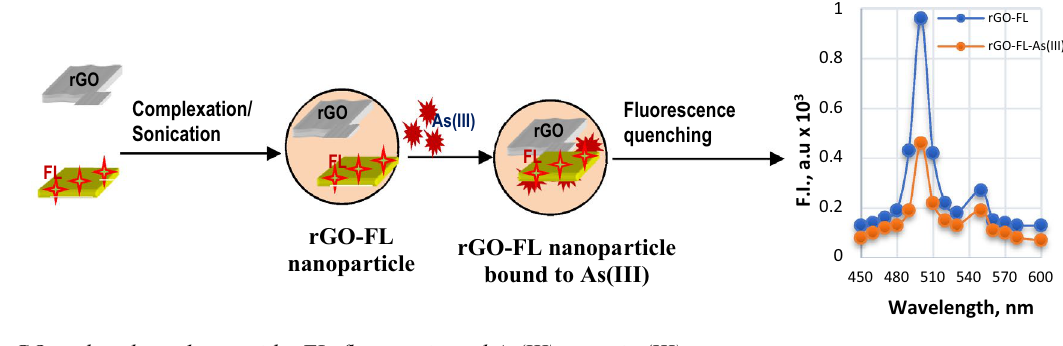
rGO, reduced graphene oxide; FL, fluorescein and As(III), arsenic (III) Figure 1. The sensing schematic of rGO–FL nanosensor for As (III)